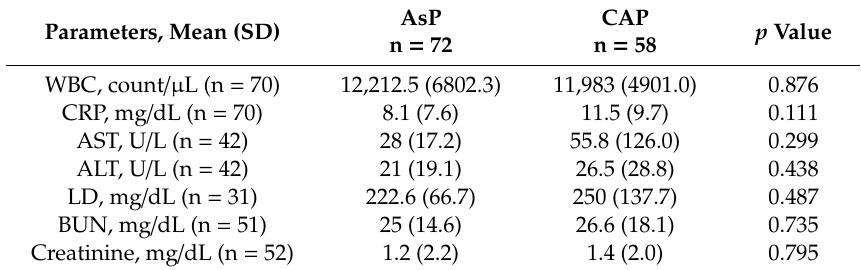
Table 3. Laboratory findings (available in limited patients) of the first blood tests in patients with AsP and CAP.